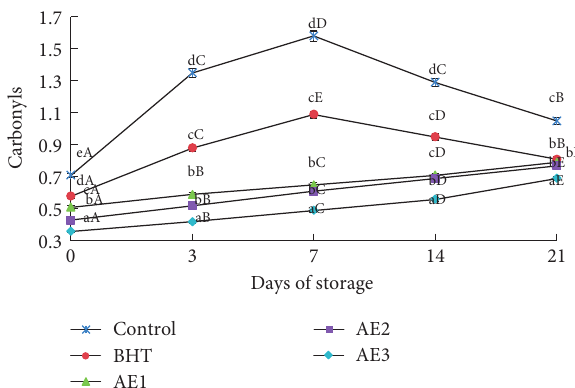
Figure 3: Effect of the aqueous pomegranate peel extract on protein carbonyl (nmoles carbonyl/mg protein) of minced beef meat during storage at 4 ° C.